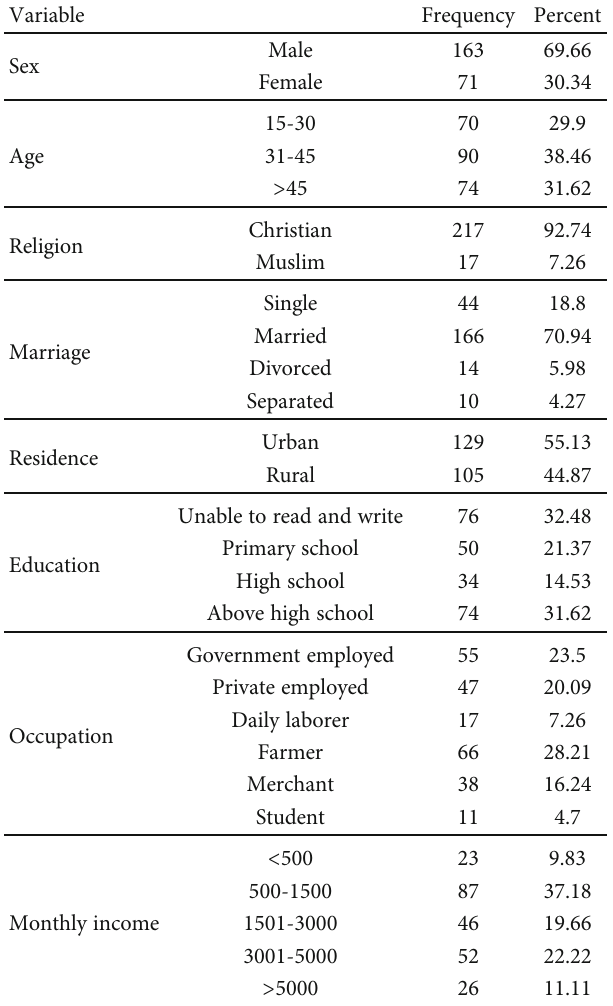
Table 1: Sociodemographic characteristics of diabetes mellitus patients at the University of Gondar Hospital, Gondar, Ethiopia,